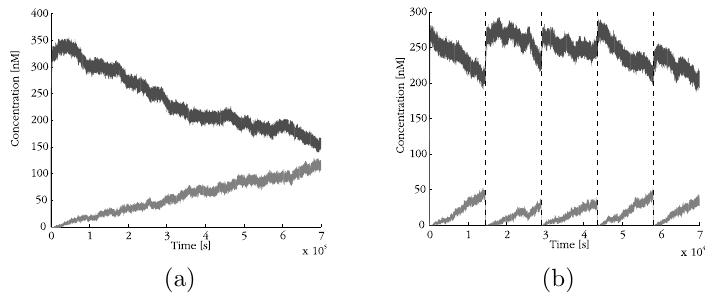
Figure 4. Time evolution of concentrations of proteins in dimerized form, where initially system is in its stable state and simulation is ran for 7 · 10 5 seconds. Figure (a) presents scenario without refreshing and Figure (b) with refreshing by temporal presence of external signals i , respectively j . Concentrations of protein dimer X 2 are presented with dark-grey line and concentrations of protein dimer Y 2 with light-grey